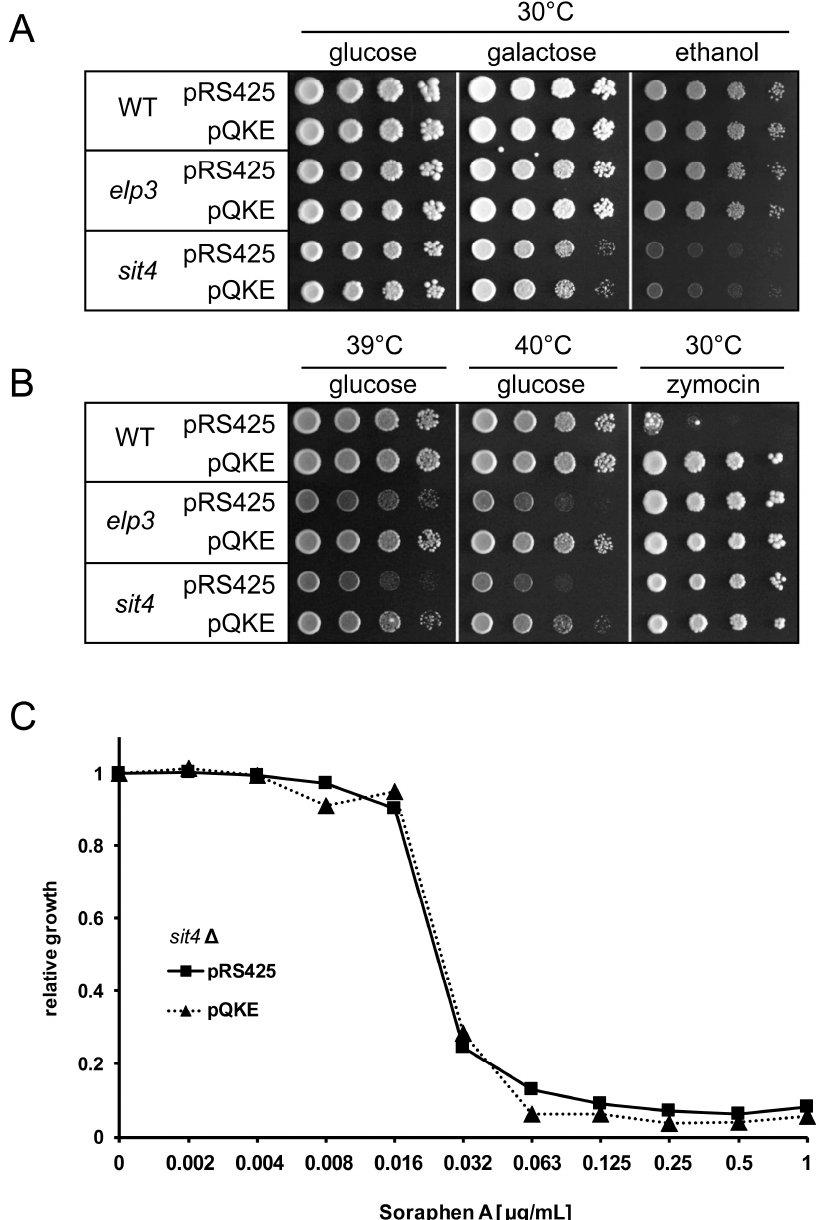
Figure 1. Phenotypes of elp3 and sit4 mutants and their responses to overexpression of tRNA Gln UUG, tRNA Lys UUU and tRNA Glu UUC. ( A ) BY4741 wild type (WT), elp3 or sit4 mutants were each transformed with empty plasmid pRS425 or pQKE (over-expression of tRNA Gln UUG, tRNA Lys UUU and tRNA Glu UUC) and subjected to drop dilution spot assays involving yeast extract peptone (YP) based media with either glucose, galactose or ethanol as the carbon source. All plates were incubated at 30 °C for 3 days. ( B ) The same strains as in ( A ) were subjected to drop dilution spot assays on yeast extract peptone dextrose (YPD) medium (carbon source glucose) cultivated at 39 °C or 40 °C or on YPD medium supplemented with a crude zymocin preparation. ( C ) Microtiter based measurement of growth inhibition by soraphen A. Relative growth refers to optical density (O.D 600 nm) of microcultures with indicated concentrations of soraphen A as compared to soraphen A free cultures. Measurements were carried out in triplicate and presented as mean with standard deviation.